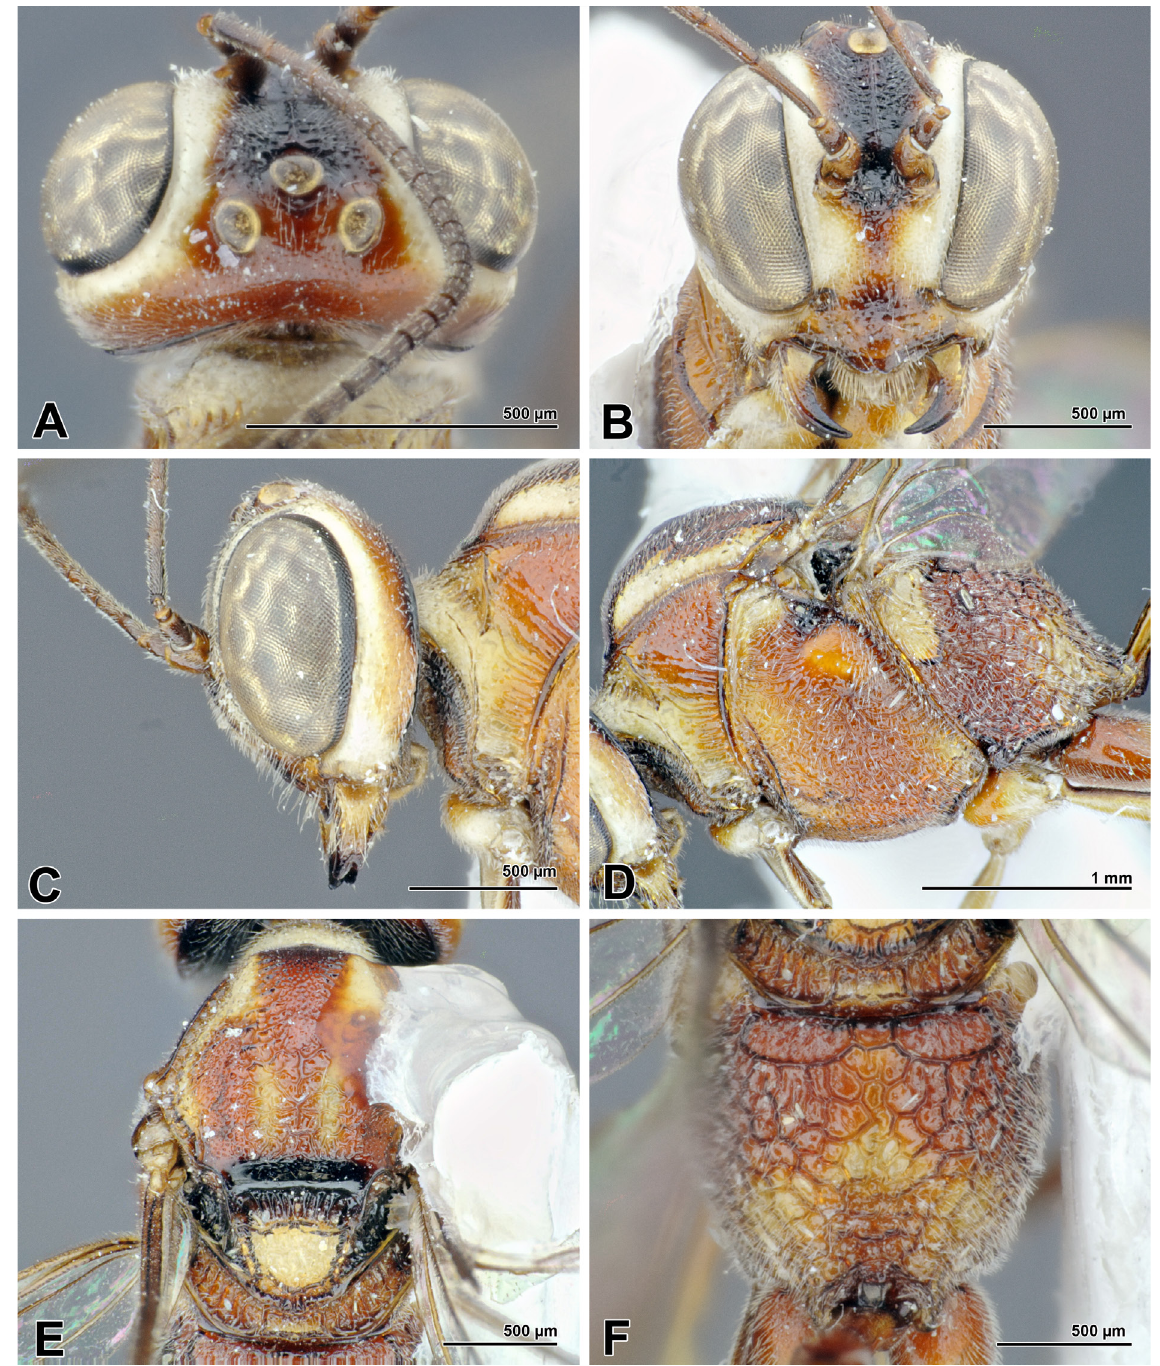
Fig. 8. Anomalon narinae Zardouei & Rakhshani sp. nov., ♀, DPPZ. A . Head, dorsal view. B . Head, frontal view. C . Head, lateral view. D . Mesosoma, lateral view. E . Mesoscutum, dorsal view. F . Propodeum, dorsal